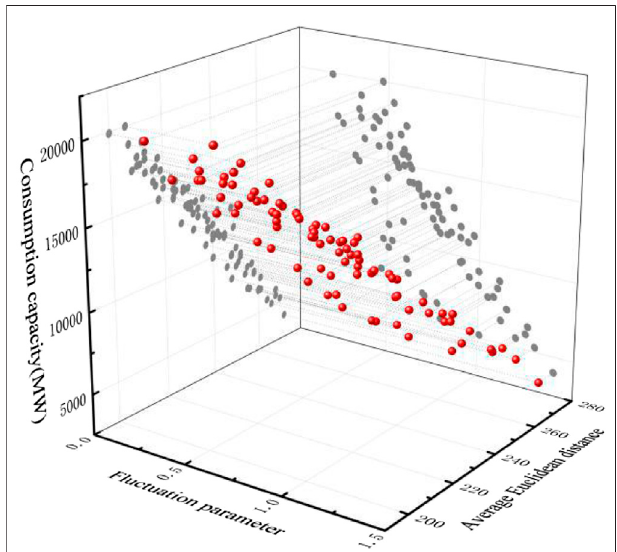
FIGURE 1 | Correlation between volatility parameters, average Euclidean distance and wind power